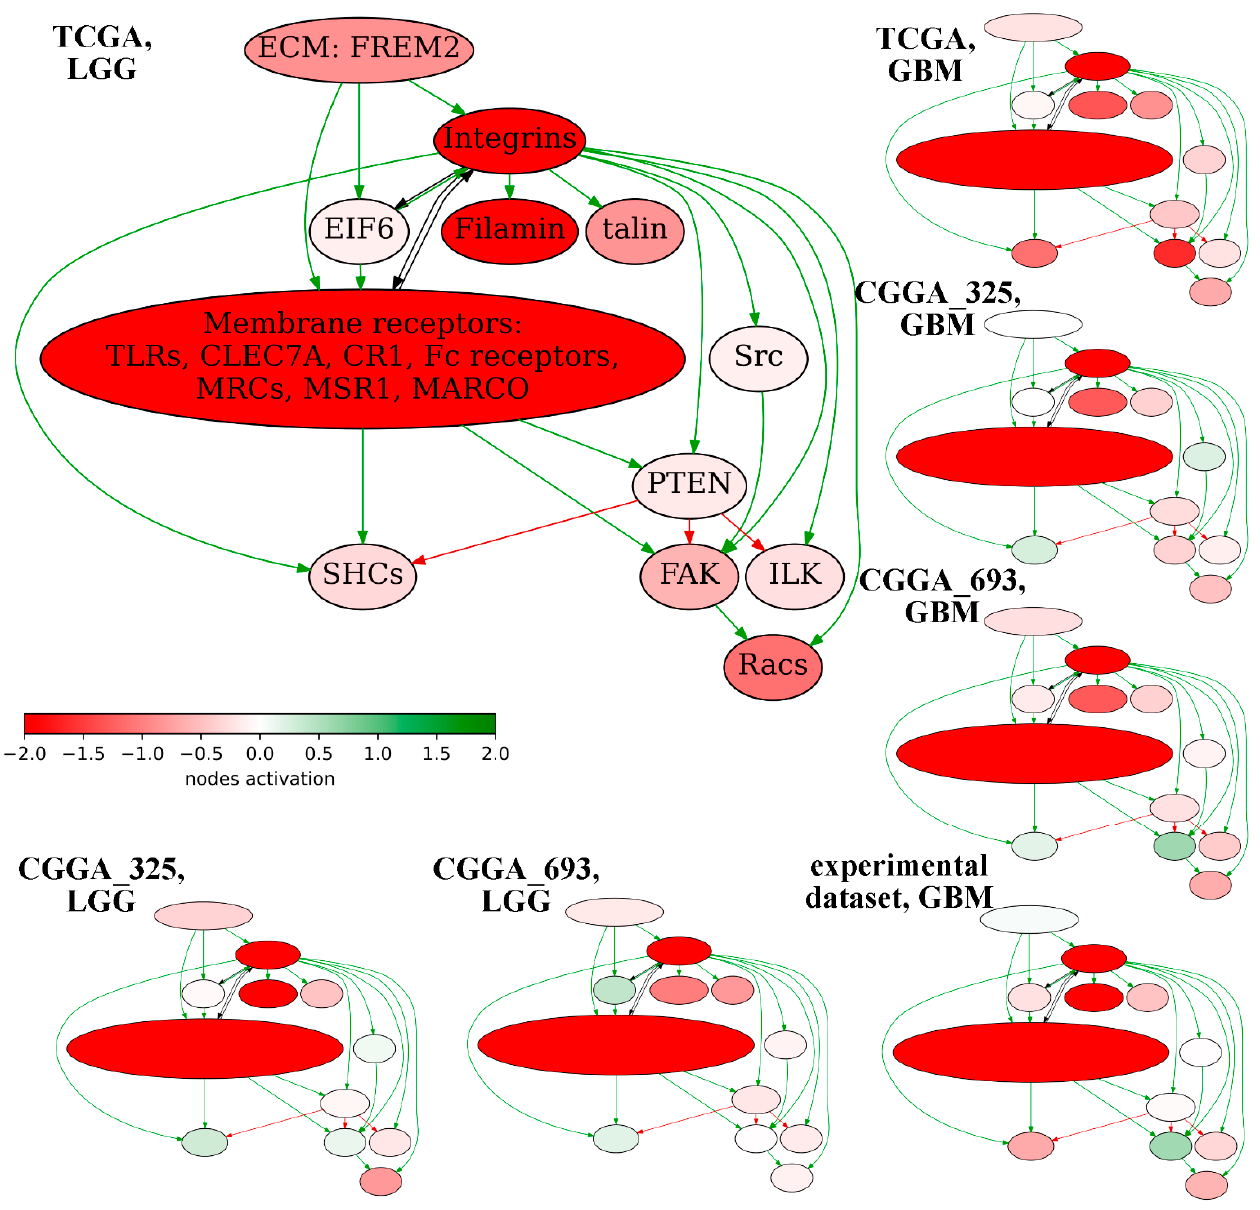
Figure 8. FREM2 pathway activation profile built for seven available glioma expression datasets. Node activation is a logarithmic ratio of expression in the averaged sample with low PAL2 (~good prognosis) to expression in the averaged sample with high PAL2 (~bad prognosis). Green arrows denote activation, red—inhibition, black –other interactions.